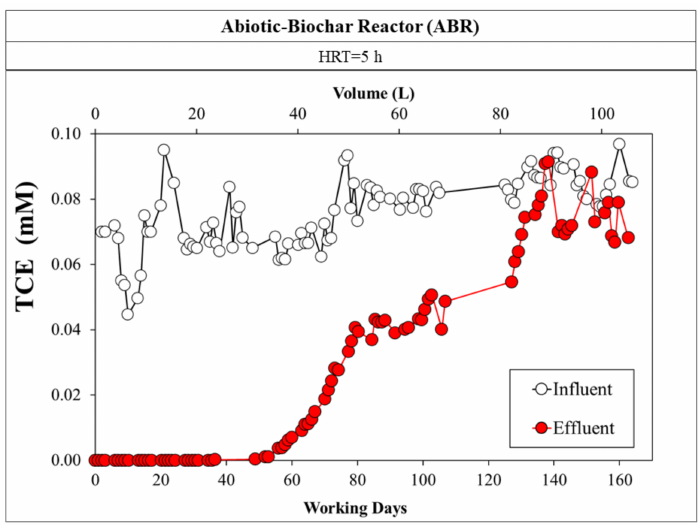
Figure 5. ABR monitoring represents the only adsorption mechanism of TCE onto the PWB. Indeed, molecules of different sizes and hydrophily are involved in multicomponent adsorption in combination with biological reactions [57], hence the chlorinated compounds were retained by the PWB with a different affinity. As a result, highly chlorinated com- pounds predominate over reducing products at adsorption sites. This behavior was con- firmed by the isotherm curve of cis-DCE onto the PWB, which showed a lower affinity with respect to TCE, in the range of 0–120 mg/L of equilibrium concentration investigated (with a maximum of 47.74 ± 7.05 mg cis-DCE/g PWB and 0.0286 ± 0.0084 L/mg as a Langmuir constant). Therefore, the TCE would have been adsorbed primarily in the early zones of the biochar bed, whereas a stratigraphic effect would occur in the rest of the reactor. After the COVID-19 lockdown in the city of Rome (Italy), run II (with 5 h of effective residence time) was monitored for 70 days (355 BVs) with a TCE average concentration of the feeding solution of about 0.10 ± 0.03 mM. As shown in Figure 4, a decrease in the incoming TCE concentration occurred in the 220 to 240-day period, due to an error when preparing the feed solution. At the outlet, only the reduction products were detected, while TCE was always below the detection limit. At the end of the test, the average of cis-DCE was 0.047 ± 0.027 mM, with 0.040 ± 0.030 mM of VC. As a result, while in the first run the relevant product was the cis-DCE, the higher residence time of run II may have stimulated the metabolism through the second step of conversion (cis-DCE to